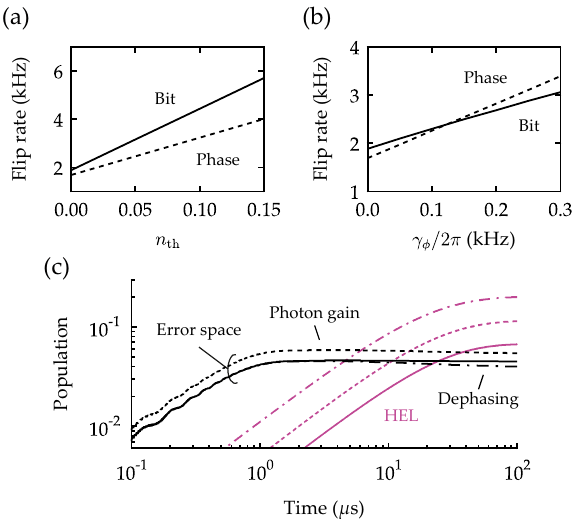
Fig. 4 Effects of single-photon gain and dephasing. a and b Bit- and phase- fl ip rates as a function of single-photon gain ( n th ) and dephasing ( γ ϕ ). The bit- and phase- fl ip rates are obtained via the same procedure depicted in Fig. 2b and c. c Population leakage to the error and HEL spaces with AQEC in the presence of single- photon gain and effective dephasing. The solid lines indicate the populations when n th = 0 and γ ϕ /2 π = 0 kHz; the dashed lines, n th = 0.15 and γ ϕ /2 π = 0 kHz; the dash-dot lines, n th = 0 and γ ϕ /2 π = 0.3 kHz. The result in c is the average of two evolutions from 0 L j i and 1 L j i ; the evolution from þ L j i yields similar results.